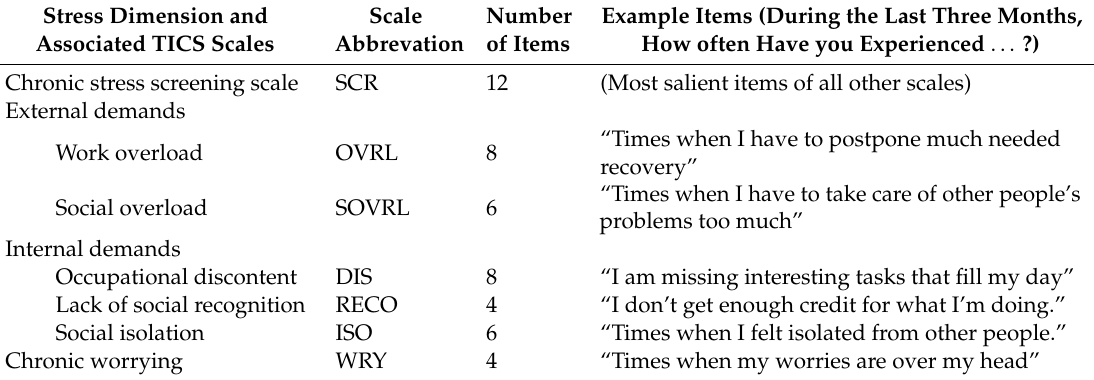
Table 2. Di ff erent scales of the Trier Inventory of Chronic Stress